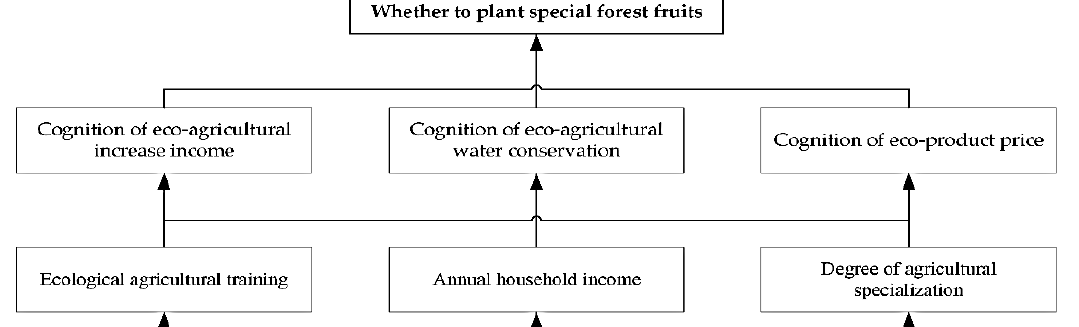
Figure 7. Explanatory structural model of whether farmers planted specialty orchard fruits. As shown in Figure 8, it can be seen that the direct factors influencing the cultivation rate of specialty orchard fruits are the cognition of eco ‐ agriculture increased income and the cognition of eco ‐ product price. In contrast, ecological agriculture training, annual house ‐ hold income, degree of agricultural specialization and agricultural cultivation scale are sig ‐ nificant influencing factors. As can be seen above, the critical paths influencing the cultiva ‐ tion rate of specialty orchard fruits by farmers are mainly along with the following relation ‐ ship: “ecological agriculture training, annual household income, degree of agricultural